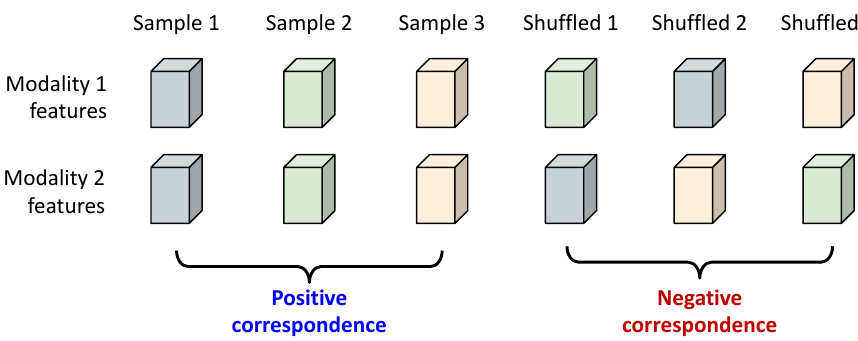
Figure 2. An illustration of the sample generation process for correspondence learning. Two modali- ties are shown, and the feature pair from the same sample (the leftmost three columns) is regarded as positive correspondence; after shuffling, the feature pair for which features are not from the same sample is regarded as negative correspondence. Note that all feature pairs are used for the auxiliary correspondence learning, and only the leftmost three feature pairs are used to train the original